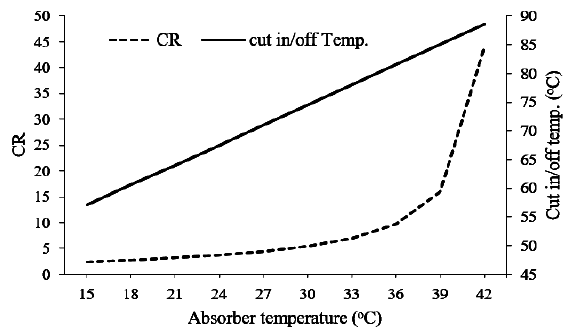
Figure 26. Effect of T abs on CR and cut in/off Temperature.